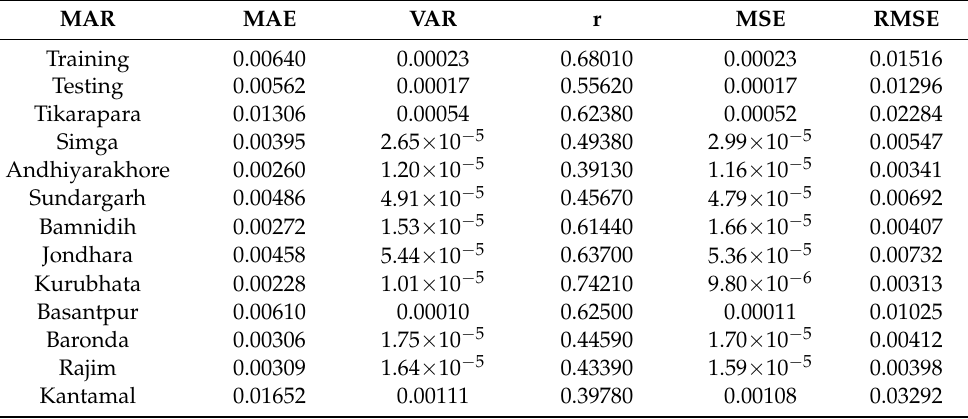
Table 7. Error statistics of single forecasting MAR model at each